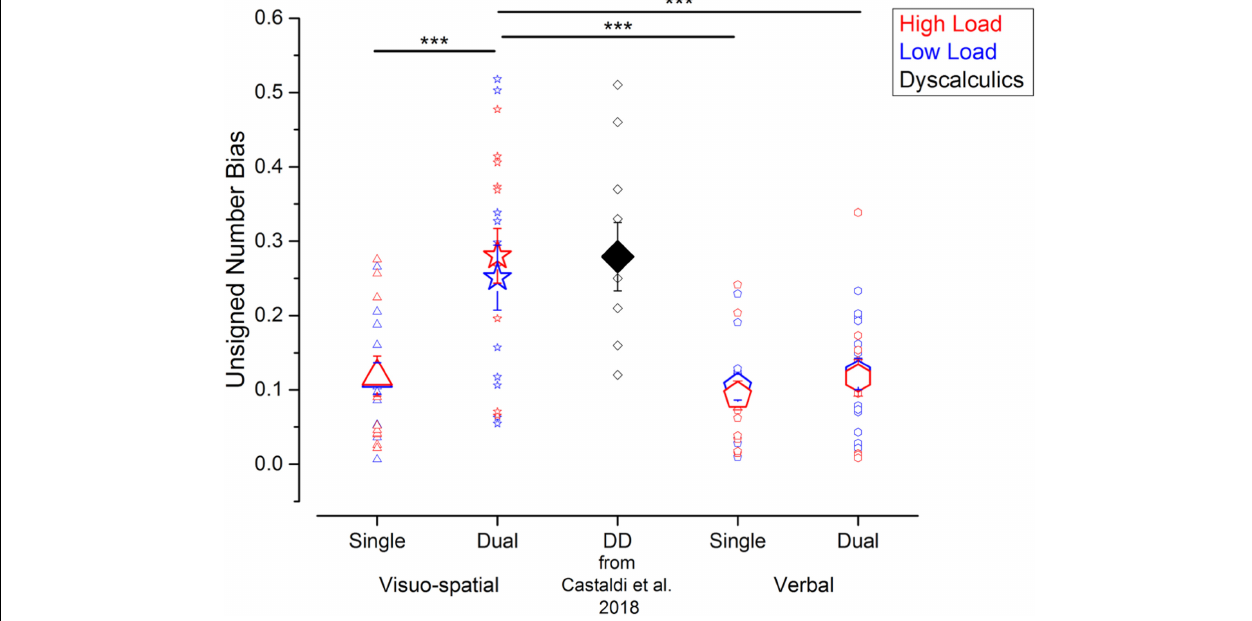
Frontiers in Human Neuroscience |